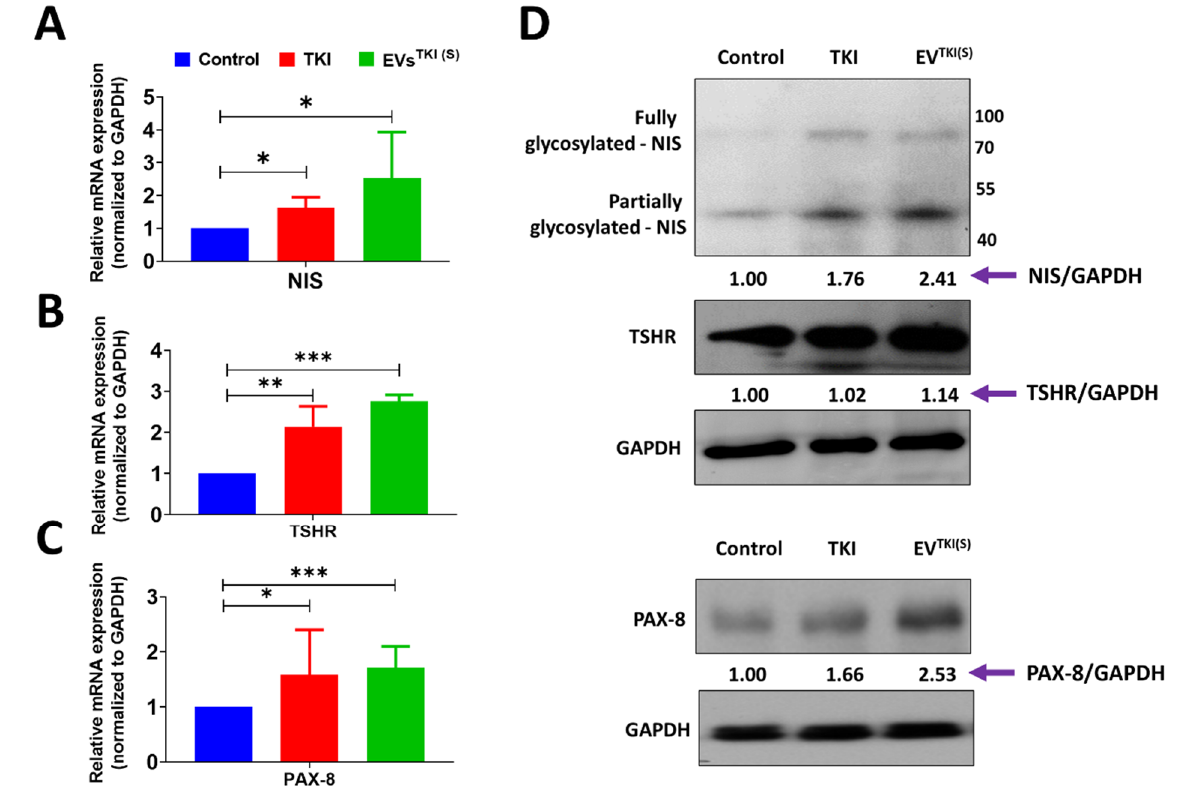
Figure 6. Enhancement of mRNA and protein expression levels in ATC cells after EVs TKI(S) treatment. The SW1736 cells were exposed to DMSO (0.5 µg/mL), TKI (0.5 µg/mL), and EVs TKI(S) (0.5 µg/mL) for 72 h. ( A – C ) mRNA expression levels of NIS, TSHR, and PAX-8 in ATC cells; GAPDH was used as a housekeeping gene ( n = 3). Data are expressed as mean ± SD. ( D ) Western blot analysis of NIS, TSHR, and Pax-8 levels in ATC cells. GAPDH was used as the loading control. Band intensity was measured using GelQuant.NET software (version 1.8.2) (BiochemLabSolutions.com, CA, USA). *** p < 0.001, ** p < 0.01, * p < 0.05 (by Student’s t- test). TSHR: TSH receptor; PAX-8: paired box-8.